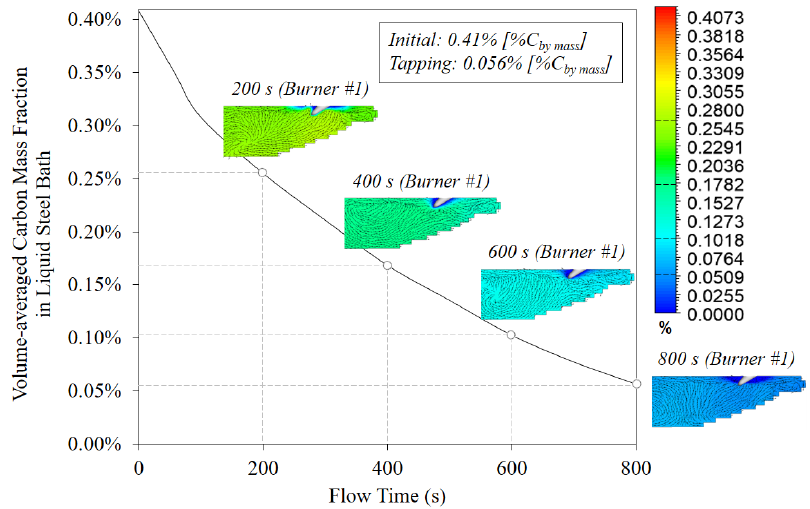
Figure 10. Volume-averaged liquid steel bath temperature variation over time.